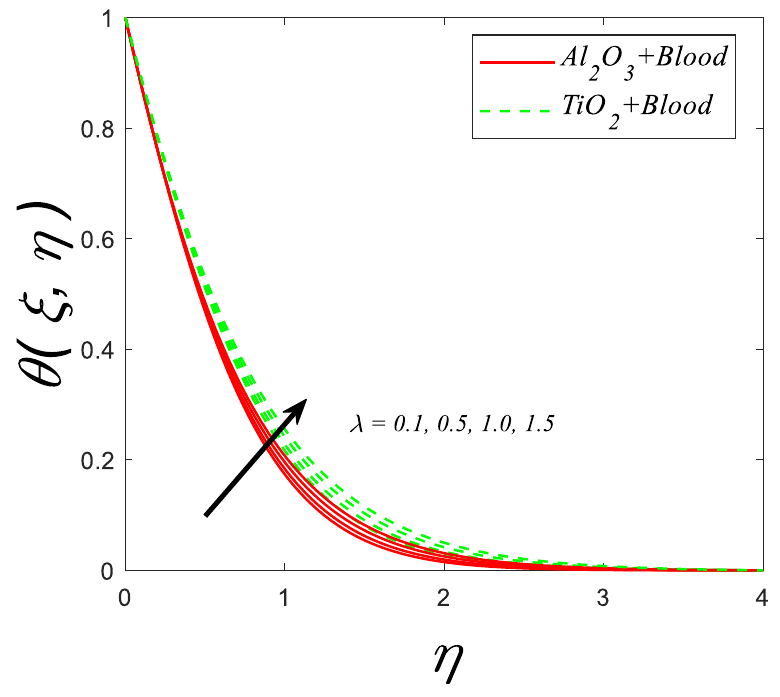
, 𝑅𝑑 = 0.1,𝐺𝑟 = , Rd = 0.1, Gr = 0.1, 3 3